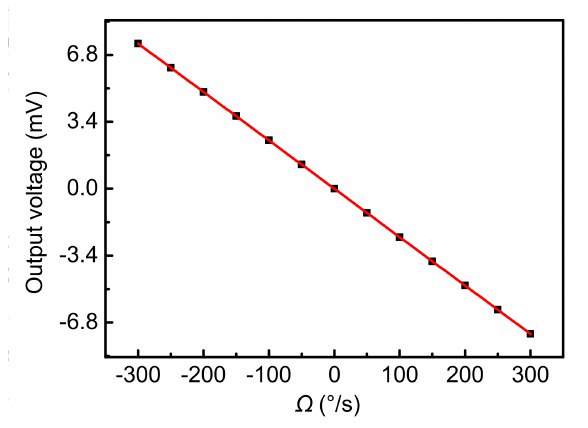
Figure 9. The curve of input angular rate and output